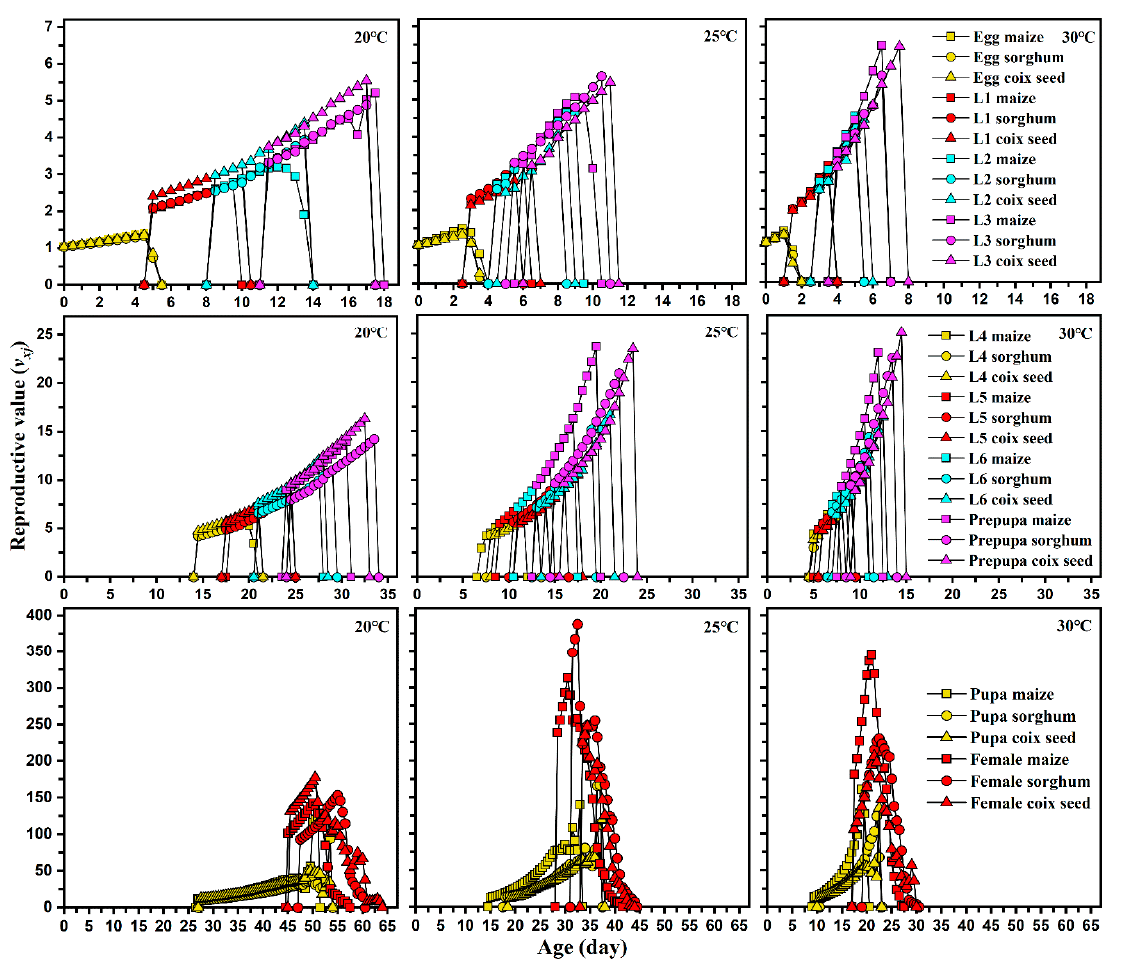
Figure 4. Age-stage reproductive value ( v xj ) of each developmental stage of Spodoptera frugiperda on different hosts and at different temperatures.